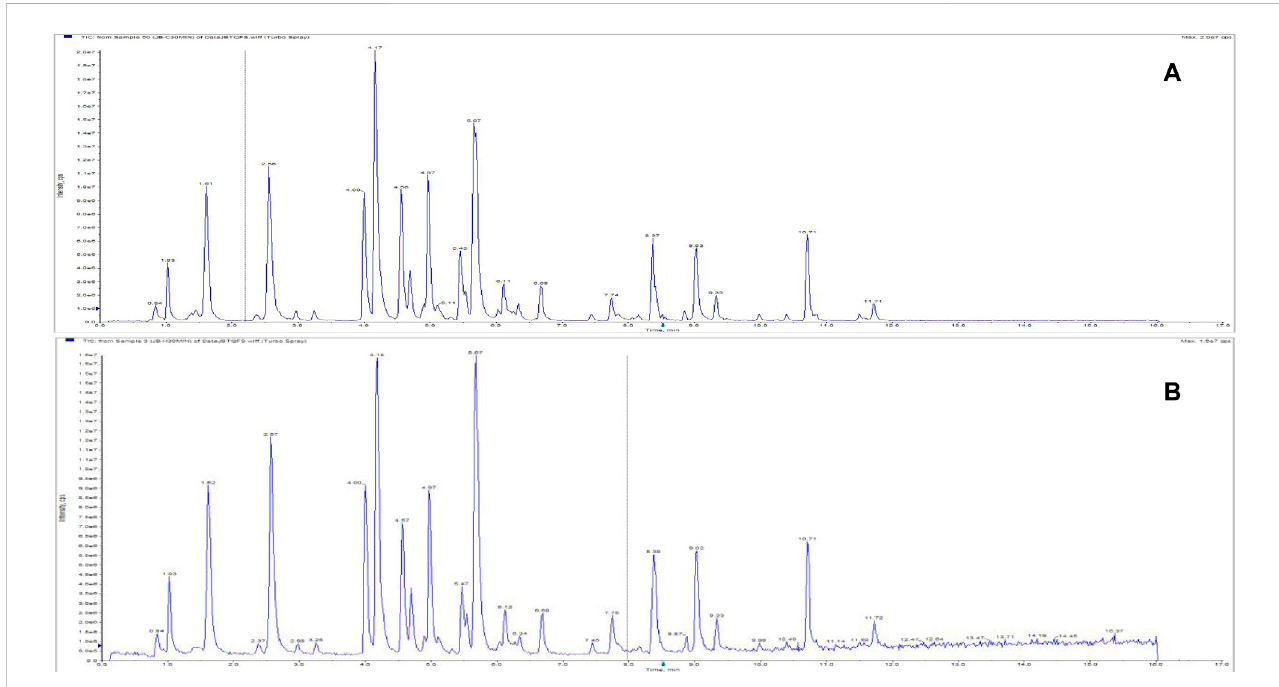
FIGURE 10 Total ion chromatograms of Jinbei oral liquid by different extraction methods. (A) Ultrasonic; (B) re fl ux See Supplementary Data Sheet